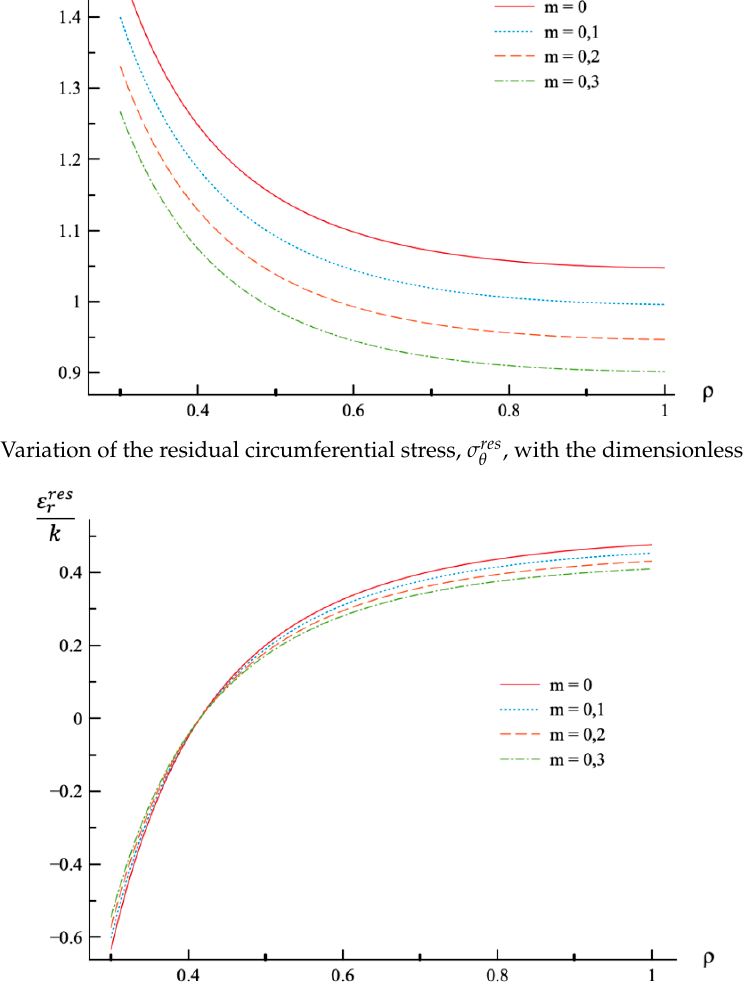
Figure 8. Variation of the residual radial strain,